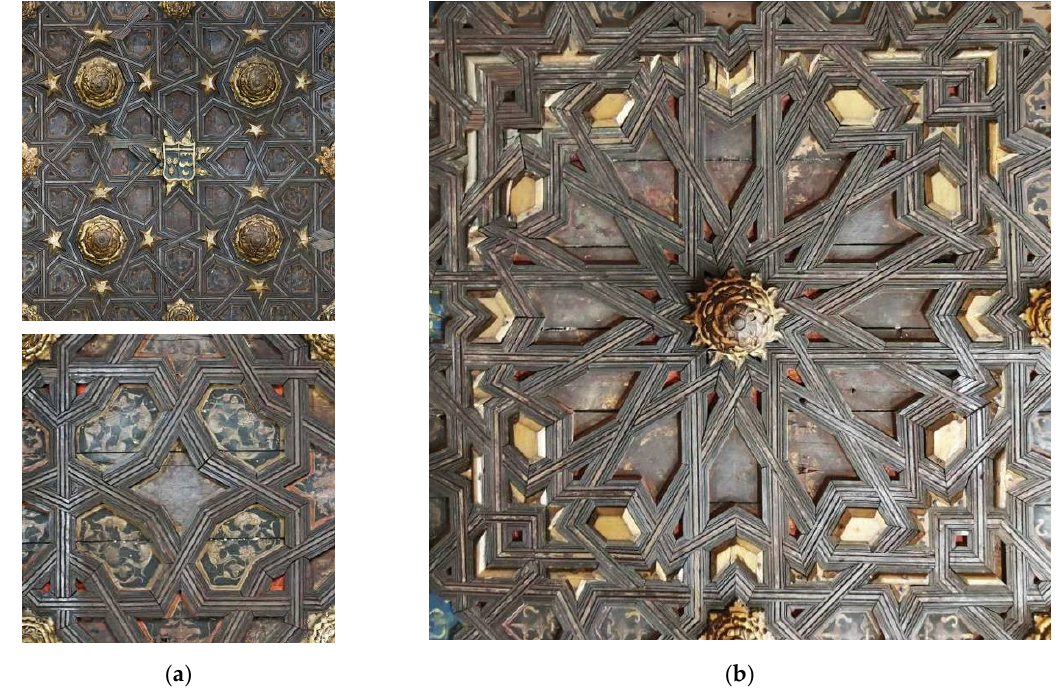
Figure 6. Ceiling details: ( a ) Eight-point star and “cuartillejos”. ( b ) “Cuartillejo” with a 12-point star. Authors’ own photographs, 2020.